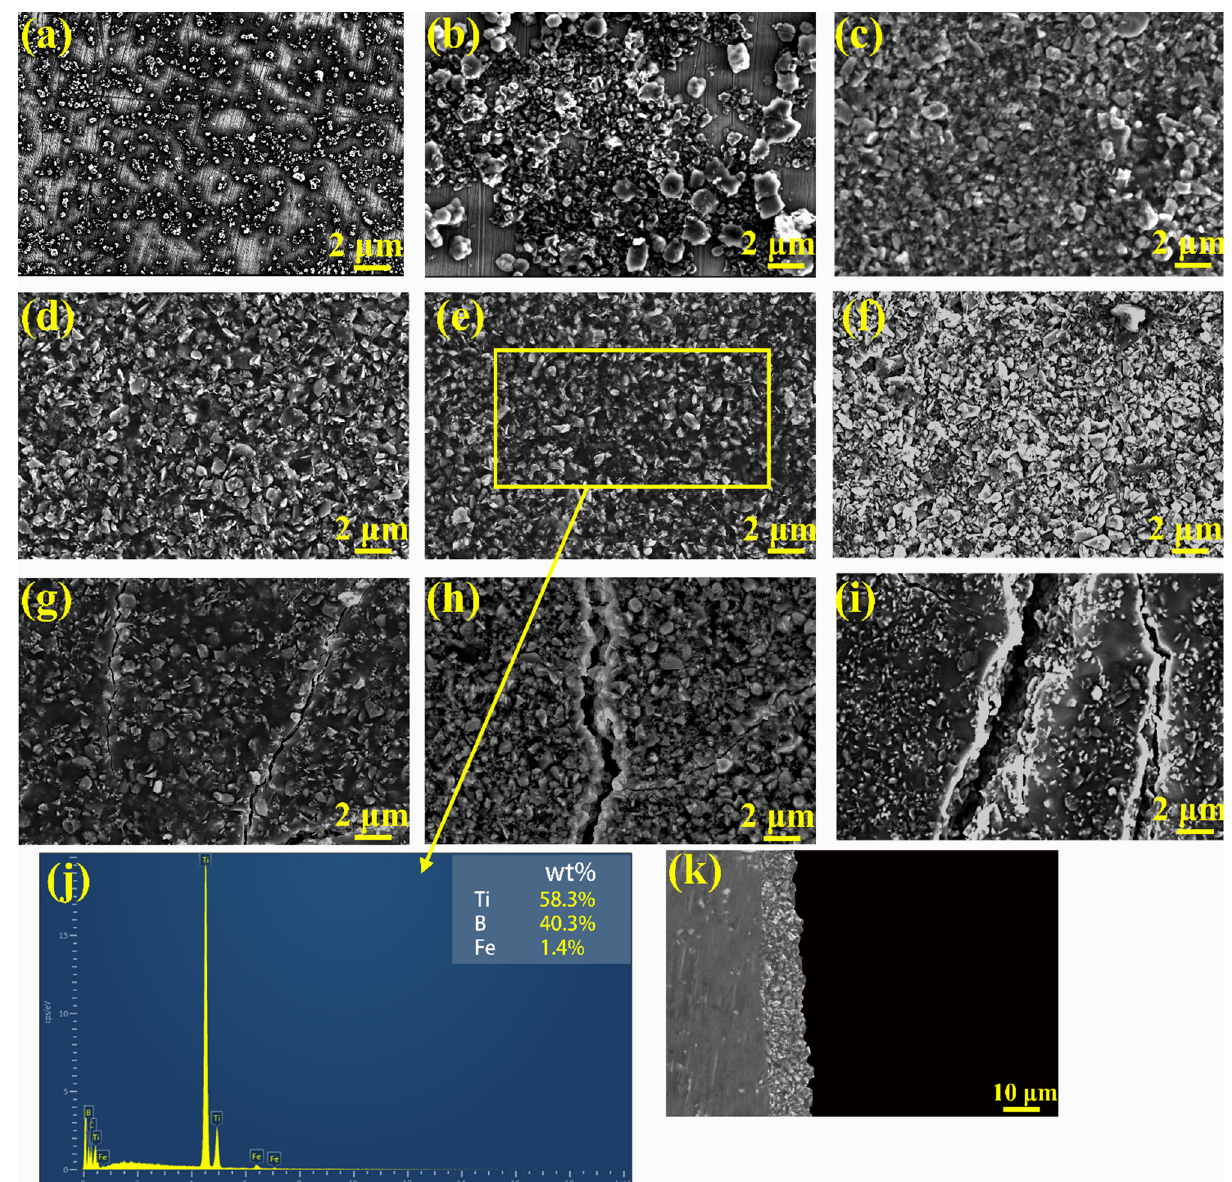
Figure 4. Microstructures of the coating and the thickness of the coating: ( a ) 20 V, 30 s, ( b ) 20 V, 60 s, ( c ) 20 V, 120 s, ( d ) 40 V, 30 s, ( e ) 40 V, 60 s, ( f ) 40 V, 120 s, ( g ) 60 V, 30 s, ( h ) 60 V, 60 s, ( i ) 60 V, 120 s, ( j ) EDS results of coating and ( k ) thickness of the coating.